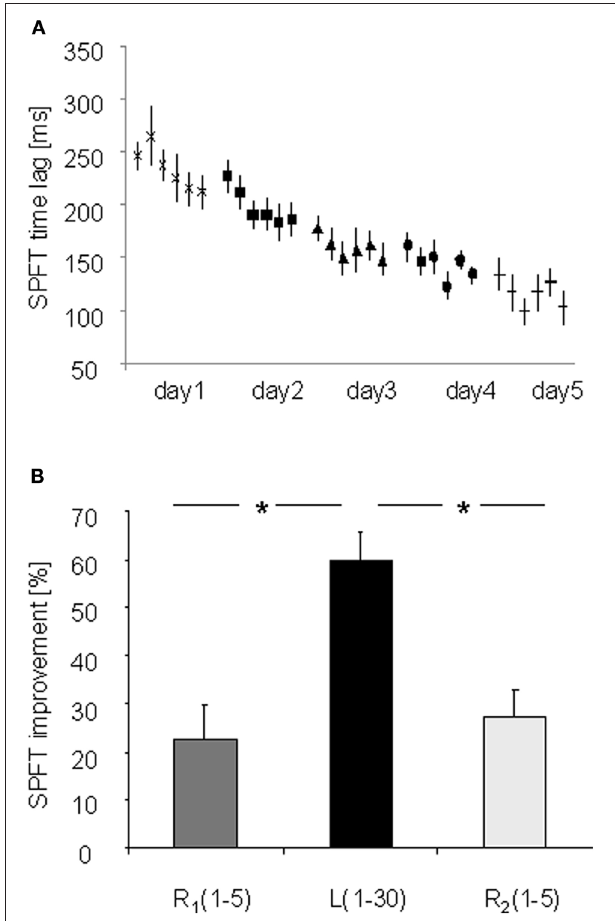
FIGURE 2 | (A) Absolute performance improvements [ms] for the learning (L) and random FEW sequence in the SPFT on 5 consecutive days (day 1–5). (B) Procedural sequence-specific learning over 5 consecutive days with the right hand. Procedural sequence-specific learning was expressed as the difference between the last trial of the random sequence (R2) versus the last trial of the learning sequence (L6) on each day. ∗ Indicates significant performance changes [Bonferroni-corrected for multiple comparisons ( p ≤ 0 .